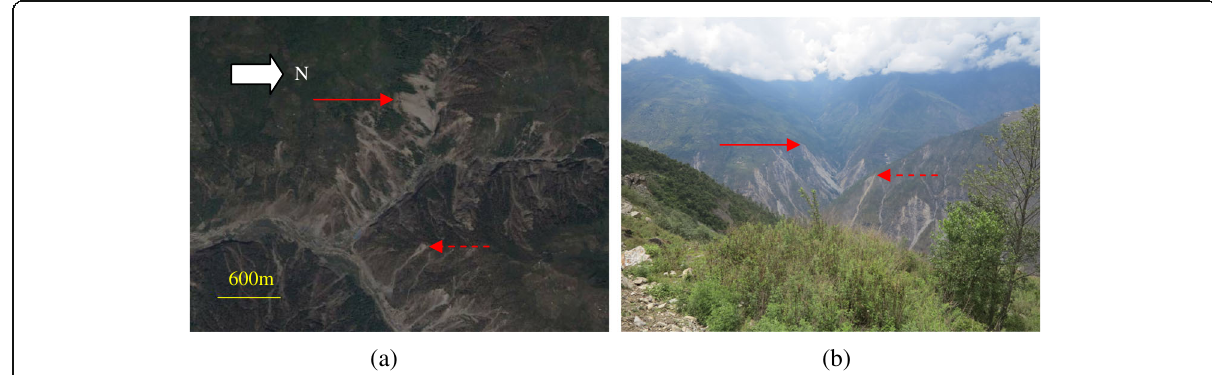
Fig. 6 An area characterized by high density of coseismic landslides. a Satellite image taken on 3 May 2015. b Field photo taken on 15 June 2015 (by Chong Xu, view to west). The solid and dotted arrows denote the same places,